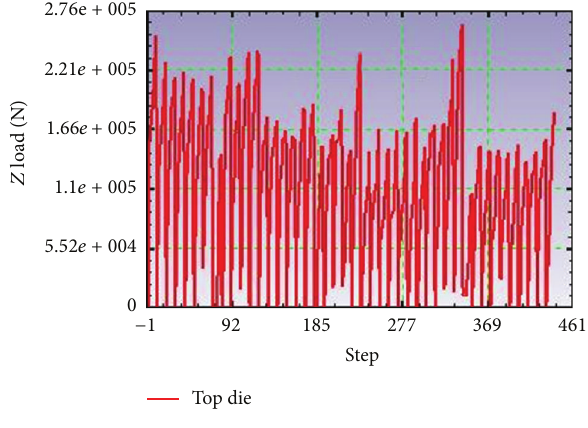
Figure 9: Forming loads of